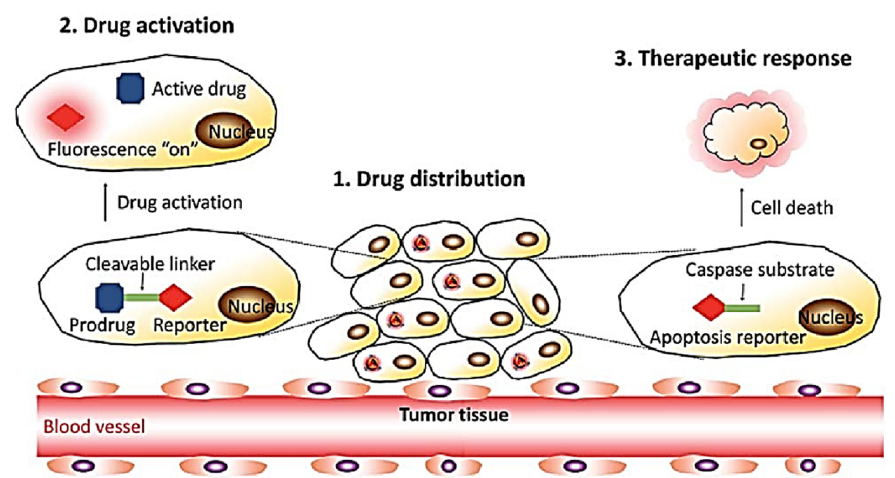
Figure 23. Diagrammatic representation for the AIEgens utilized for therapeutic approach involved in drug distribution and drug activation in situ via drug delivery system (DDS)-based molecules. Reprinted from reference [130] with the permission of The Royal Society of Chemistry.